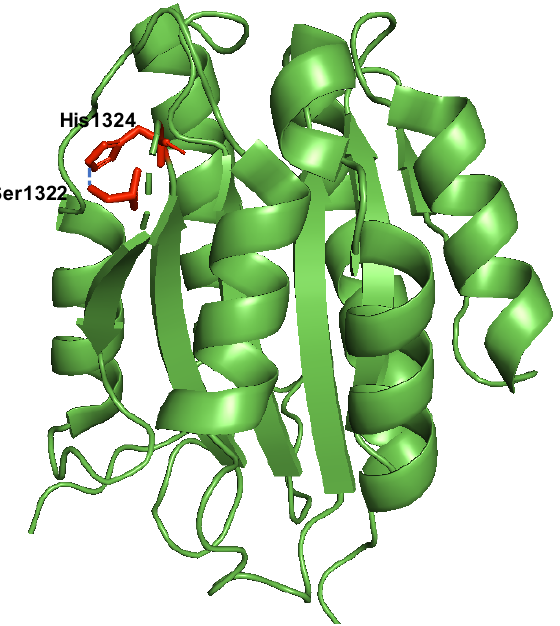
Figure 3: Structure of the type 2M p.Gly1324Ser VWF A1 domain (PDB accession code 5BV8) [64]. The dashed line shows the hydrogen bond between the hydroxyl group of Ser1324 and the imidazole of His1322. This hydrogen bond contributes to rigidify this part of the domain, rendering it much less sensitive to external shear forces. The figure is generated by the program Pymol (v.